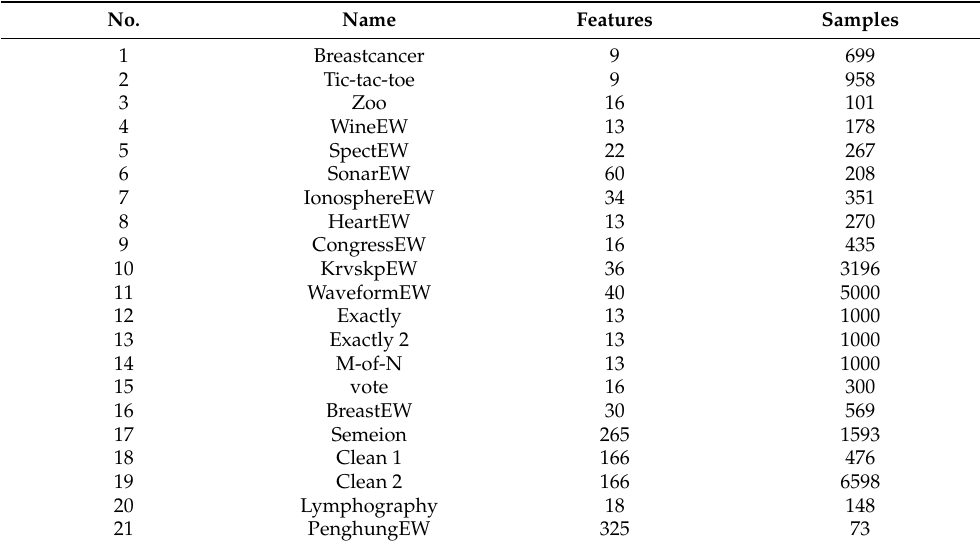
Table 9. Experimental setup